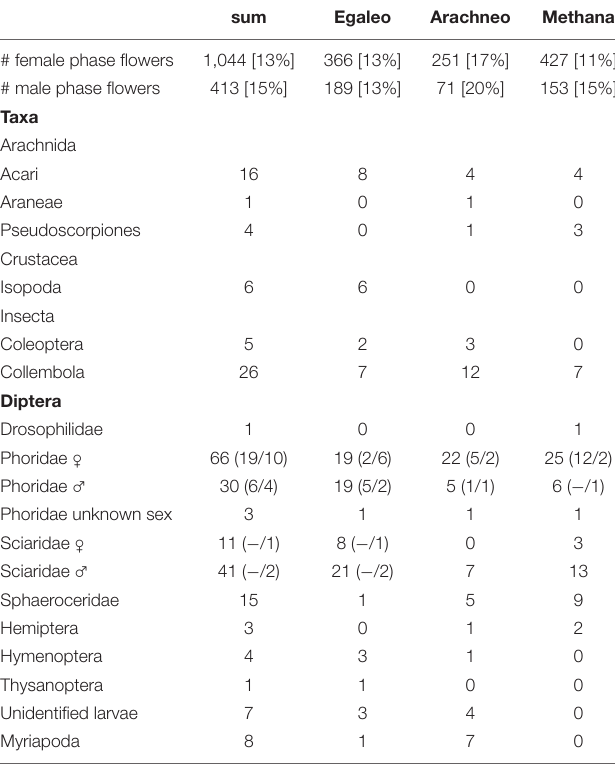
TABLE 2 | Flower visitors of Aristolochia microstoma collected at the three study sites in Greece (Egaleo, Arachneo, and Methana), shown overall (sum) and per